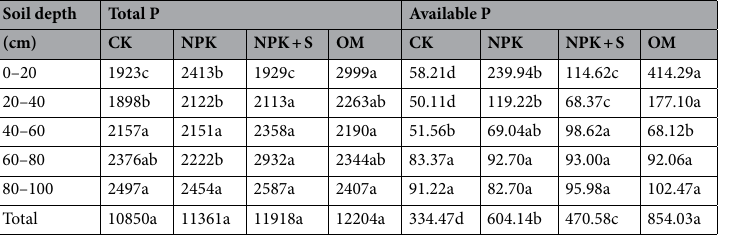
Table 2. The effect of different treatments on total phosphorus (P) and available P accumulation in soil profiles (kg ha −1 ). CK, no fertilizer application, NPK: chemical fertilizer application, NPK + S: chemical fertilizer plus maize straw incorporation, OM: organic manure application. Values followed by different letters at the same row differ significantly at P < 0.05.